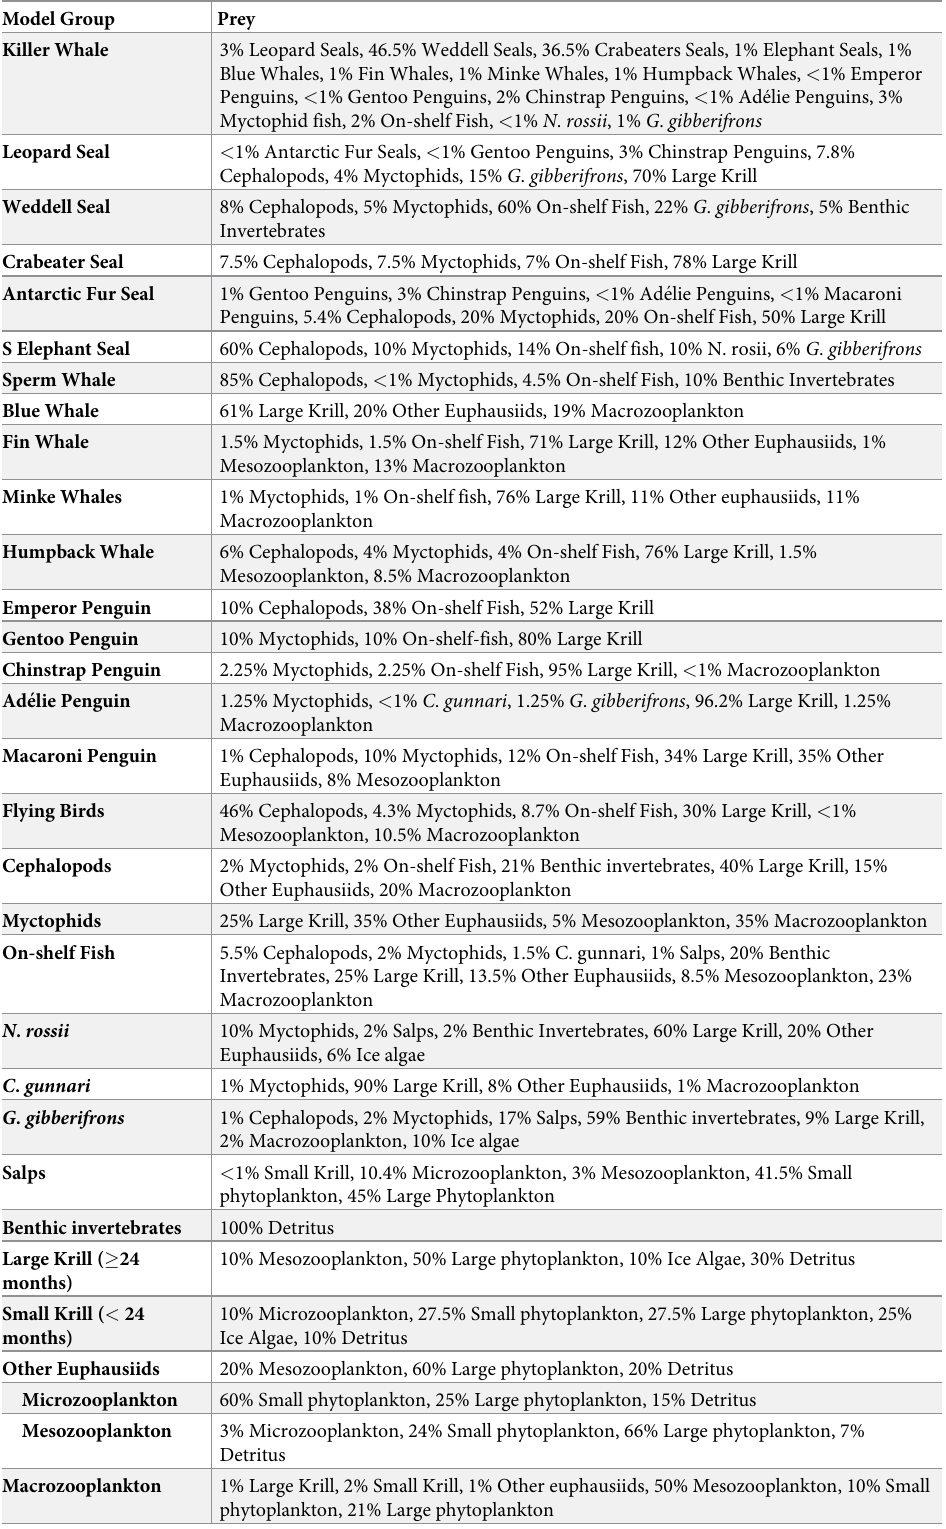
Table 1. Final diet